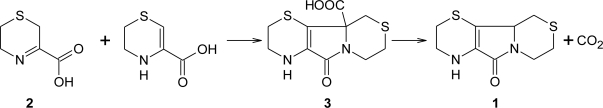
Hypothetical pathway leading to the in vivo synthesis of 1.